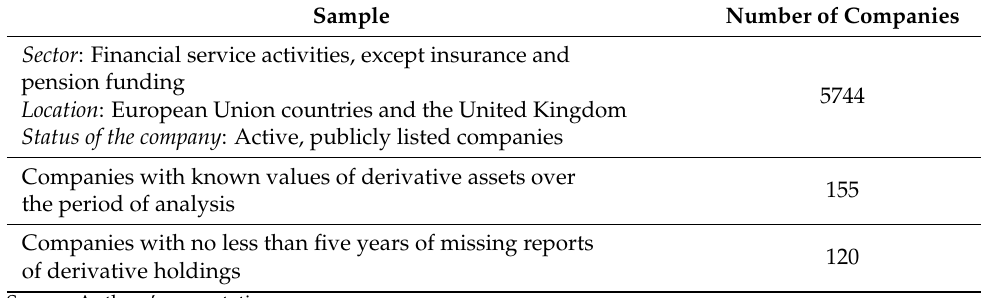
Table 1. Sample of analysis.